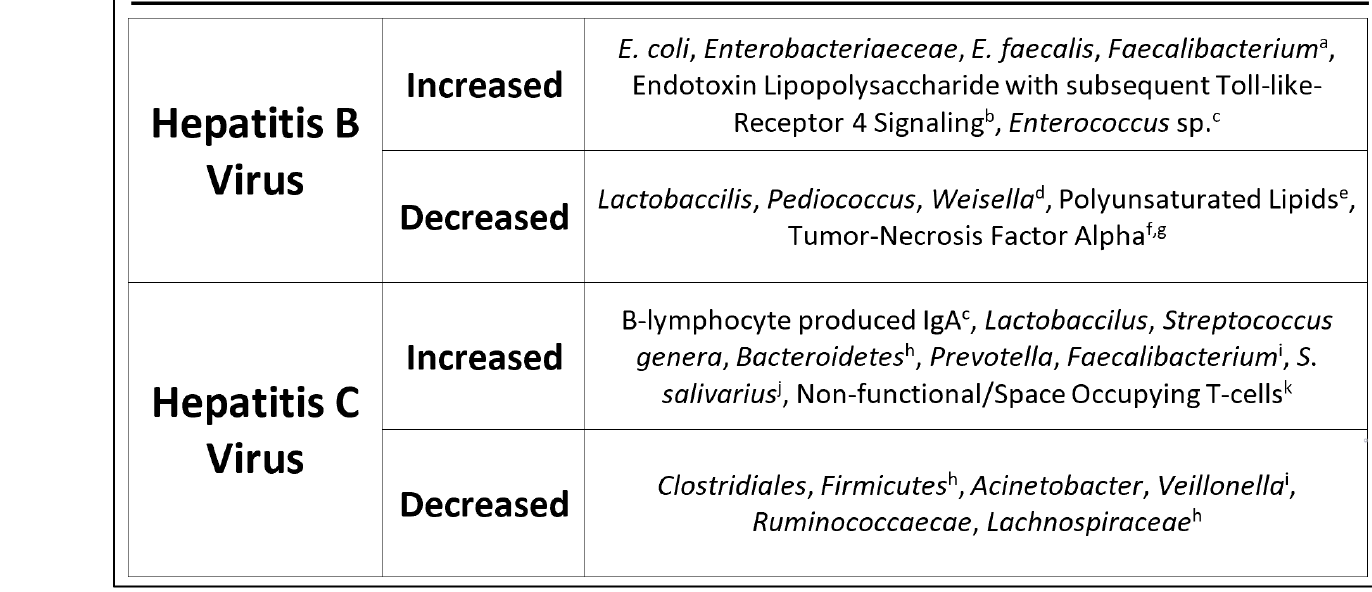
Figure 2. Upregulation and downregulation of microbes and their factors related to hepatitis B